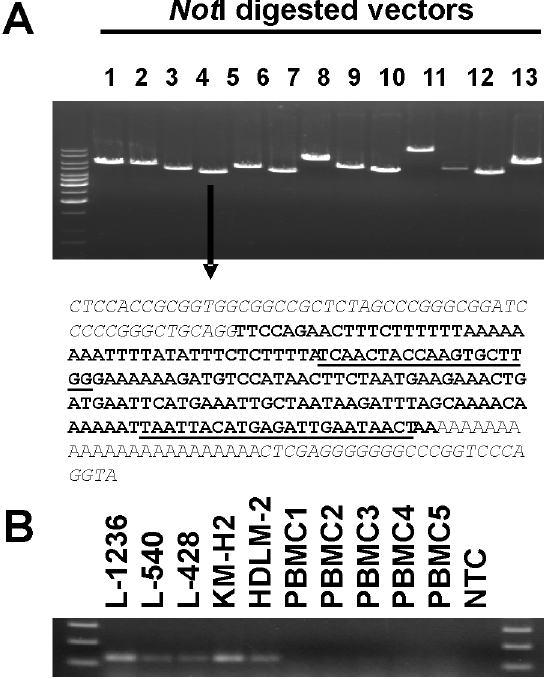
Figure 1. Identification of ERV expression in HL cell lines. (A) 13 individual vectors from a cDNA library from HL cell line L-1236 were digested with Not I, analyzed by gel electrophoresis, and sequenced as described in Material and Methods. The sequence of the insert from the shortest vector (arrow) is presented. The vector sequence is printed in italics; the insert sequence that is also present in the human genome is presented in bold type. Binding sites for the primers used in panel B are underlined. (B) Presented are results from a RT-PCR with primers (ERVK_1q42.13_library) with specificity for the sequence from panel A. cDNA from HL cell lines and normal PBMC was used as template for PCR. NTC: no template control.